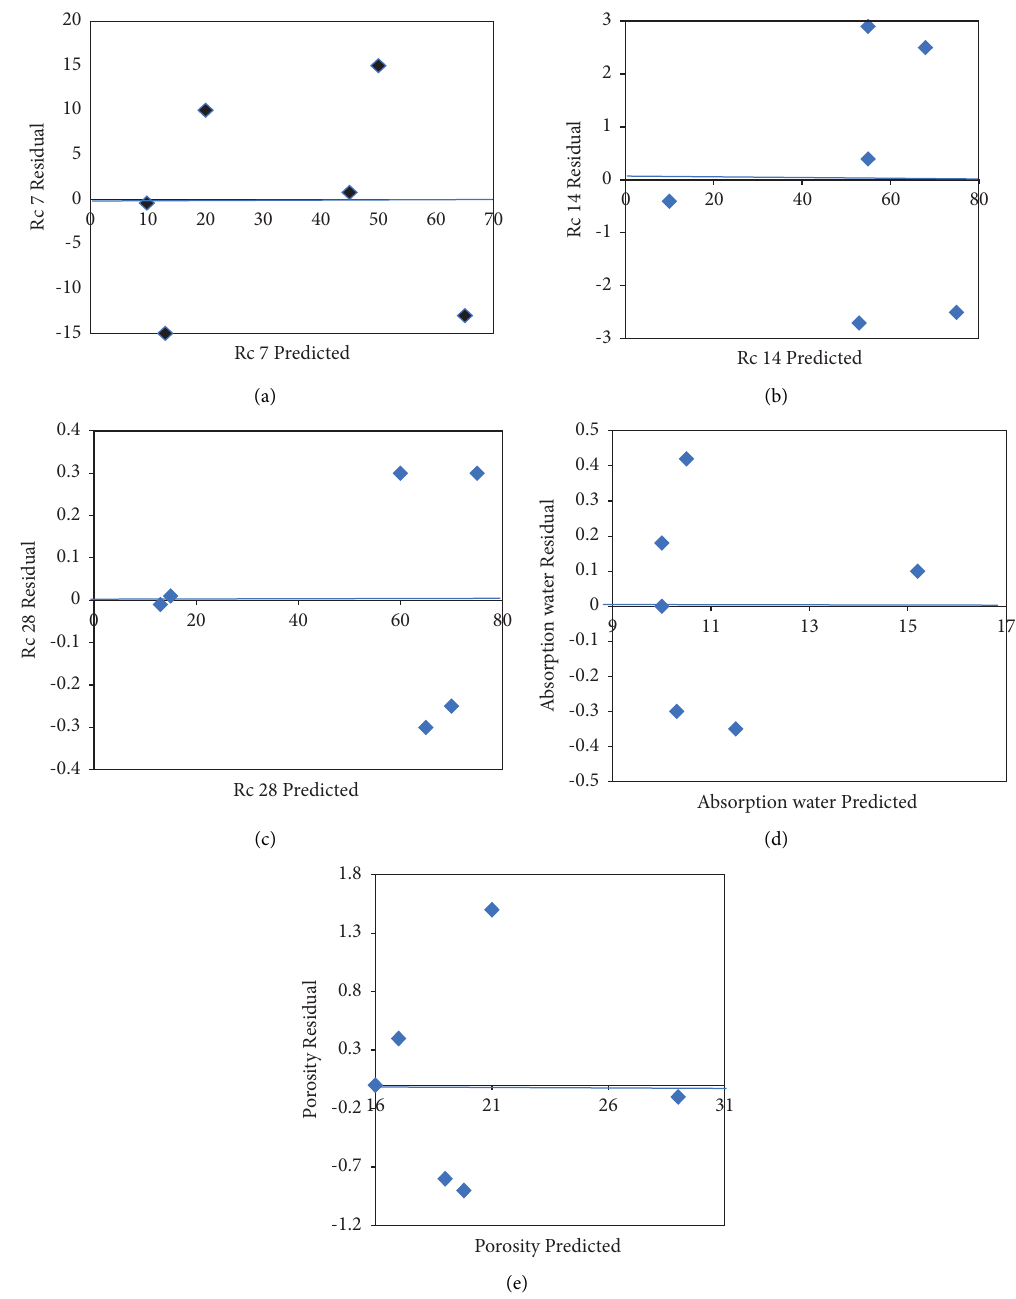
Figure 6: Te residual values according to the predicted values of RC7 (a), RC14 (b), RC28 (c), water absorption (d), and porosity (e) at 28